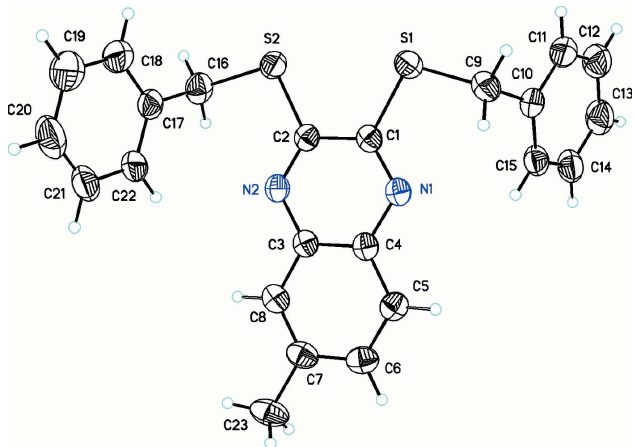
Table 1 Hydrogen-bond geometry (A˚ , (cid:2) ).